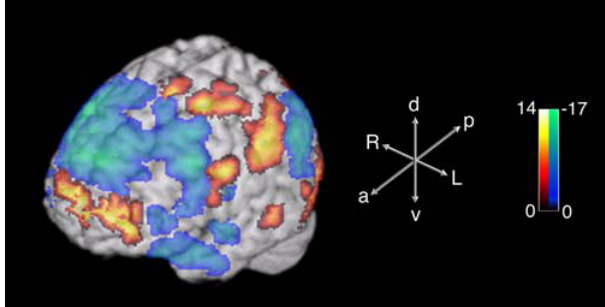
Figure 3. Three-dimensional surface projection of activations and deactivations associated with improvisation during the Jazz paradigm. Medial prefrontal cortex activation, dorsolateral prefrontal cortex deactivation, and sensorimotor activation can be seen. The scale bar shows the range of t-scores; the axes demonstrate anatomic orientation. Abbreviations: a, anterior; p, posterior; d, dorsal; v, ventral; R, right; L, left. doi:10.1371/journal.pone.0001679.g003 PLoS ONE |